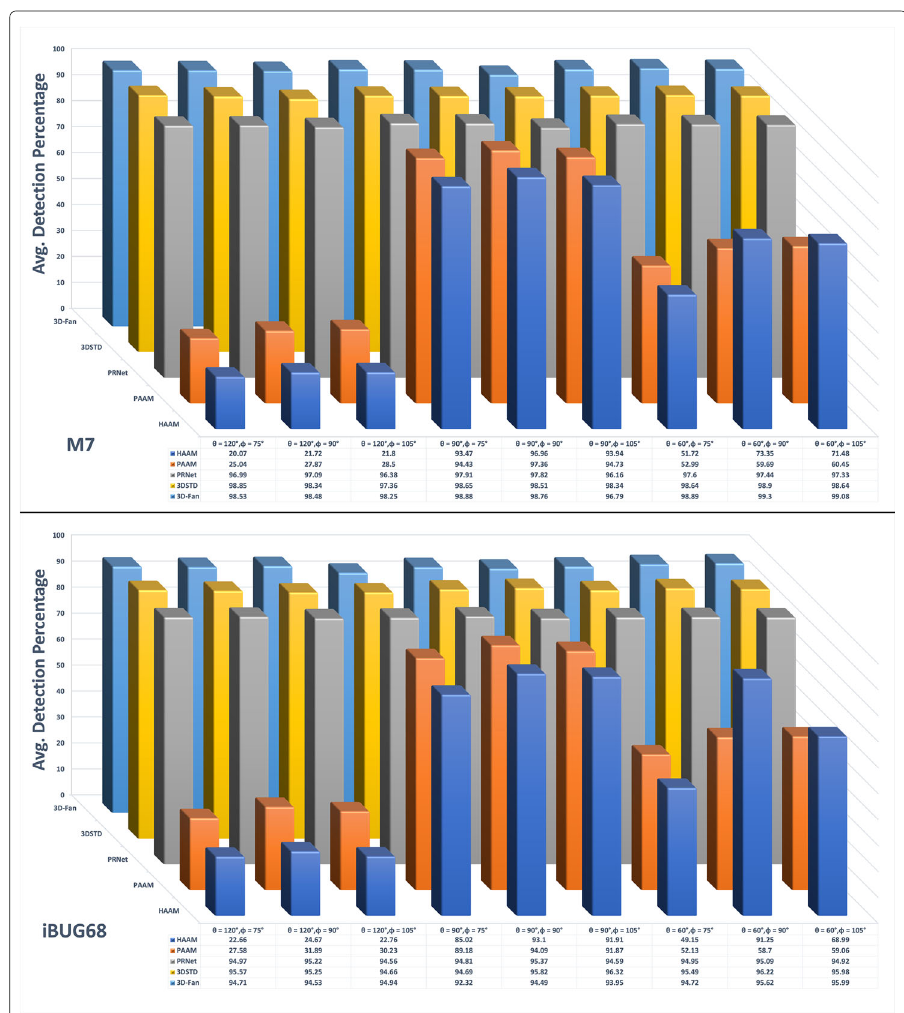
Fig. 16 Camera position with group of frontal view. The frontal view positions where φ = 75 ◦ , 90 ◦ , and 105 ◦ ; θ = 60 ◦ , 90 ◦ , and 120